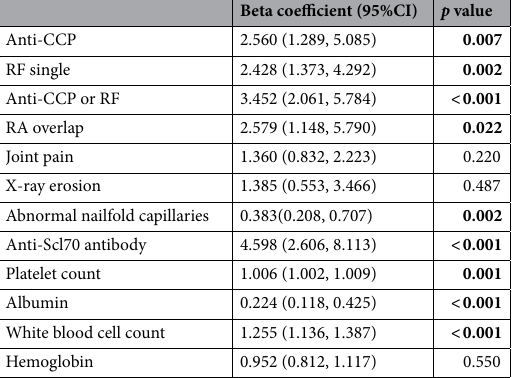
Table 6. Univariate linear regression analysis for ILD in patients with SSc. Bold text indicates statistical significance. SSc, systemic sclerosis; ILD, interstitial lung disease; RA, rheumatoid arthritis.